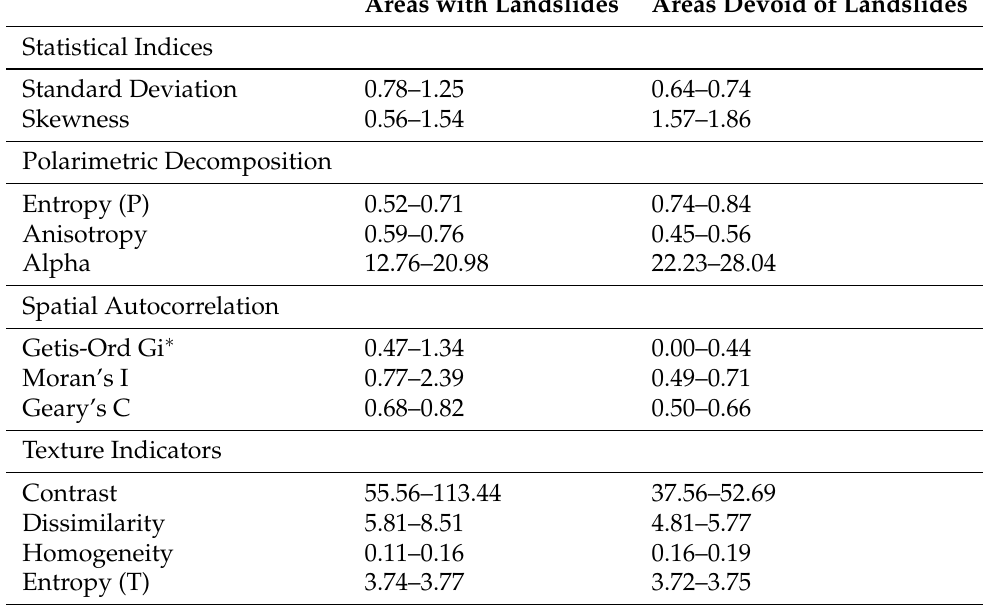
Table 2. Statistical indices for landslide areas and areas devoid of landslides in sample regions derived from ASAR LR index images, mean values for polarimetric decomposition indicators, mean values for spatial autocorrelation indicators, and mean values for texture